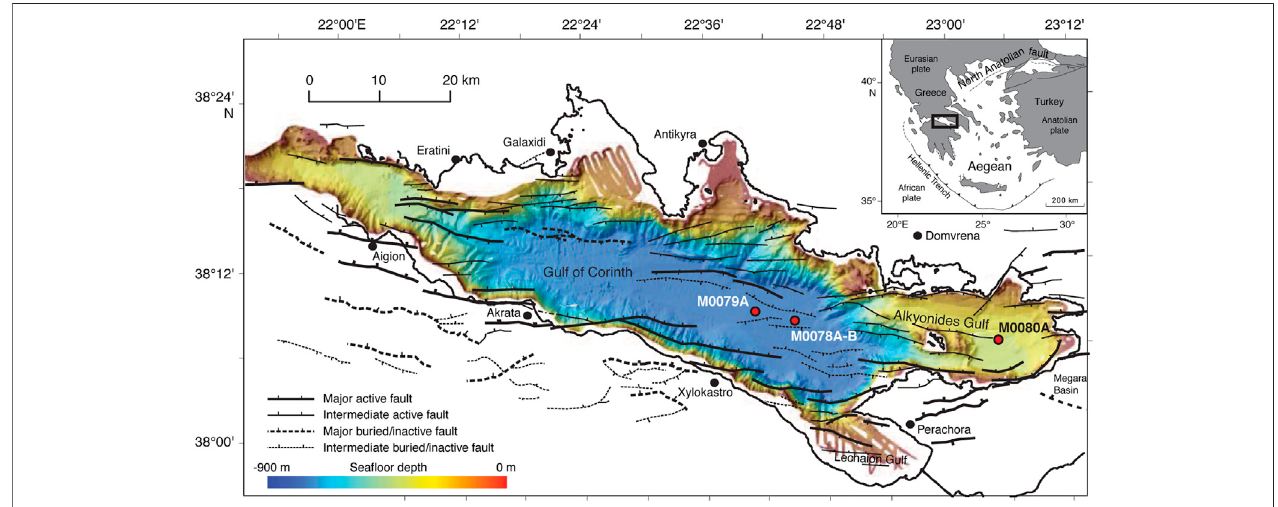
FIGURE 1 | Bathymetric and tectonic map of the Gulf of Corinth showing the location of the holes (red dots) drilled by IODP Expedition 381.